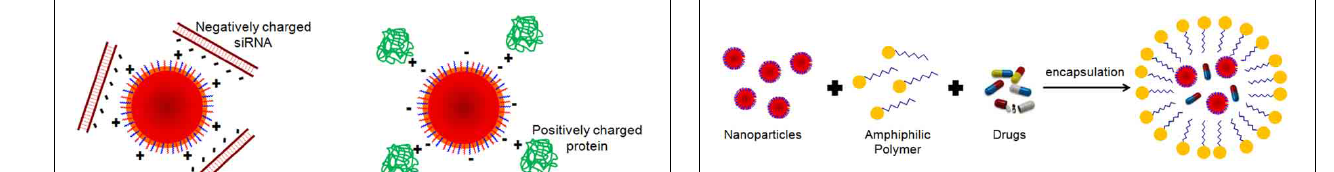
FIGURE 13 | Hydrophobic coupling. Use of amphiphilic polymers as nanoparticle and drug delivery